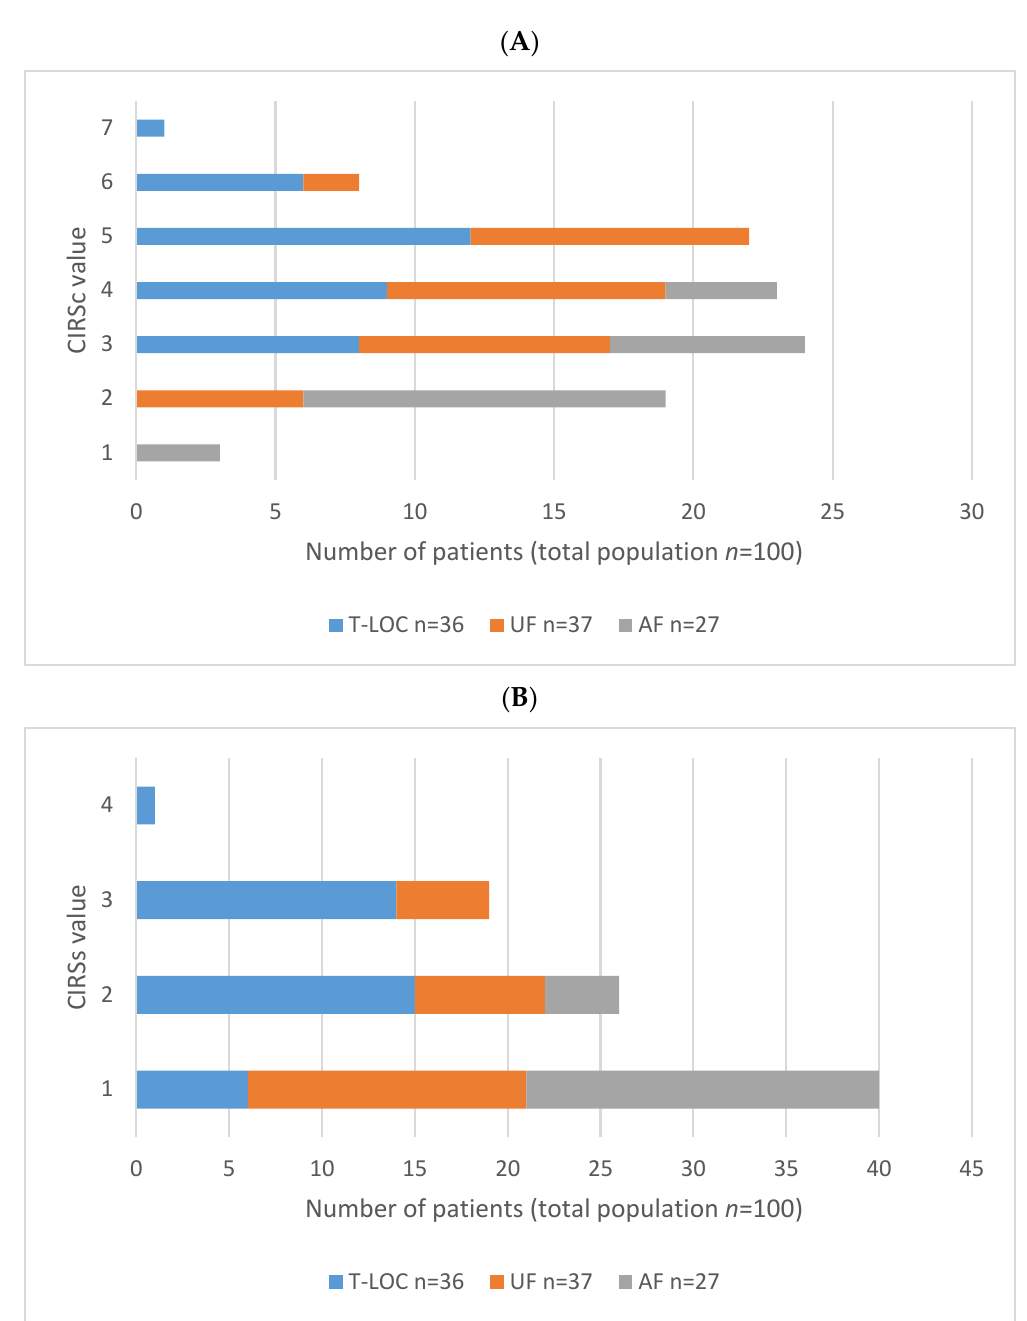
Figure 1. CIRSc ( A ) and CIRSs ( B ) distribution in T-LOC, UF and AF patients. T-LOC: transient loss of consciousness; UF: unexplained fall; AF: accidental fall; CIRSc: Cumulative Illness Rating Scale comorbidity (range 0–14, indicating the number of comorbidities); CIRSs: Cumulative Illness Rating Scale severity (range 1–5, from absent to extremely severe). Of the 36 patients with T-LOC, a relevant and specific pathological condition, possibly contributing to the syncopal episode, was identified in 33 (91%) cases. In eight patients (19%) a major cardiac disease was identified (three had an advanced atrioventricular block, two had paroxysmal atrial fibrillation at a high ventricular rate, one ventricular tachycardia, one severe aortic stenosis, one pulmonary thromboembolism), in two (6%) there was severe anemia, and in one (3%) severe hypothyroidism. Nineteen subjects (53%) had